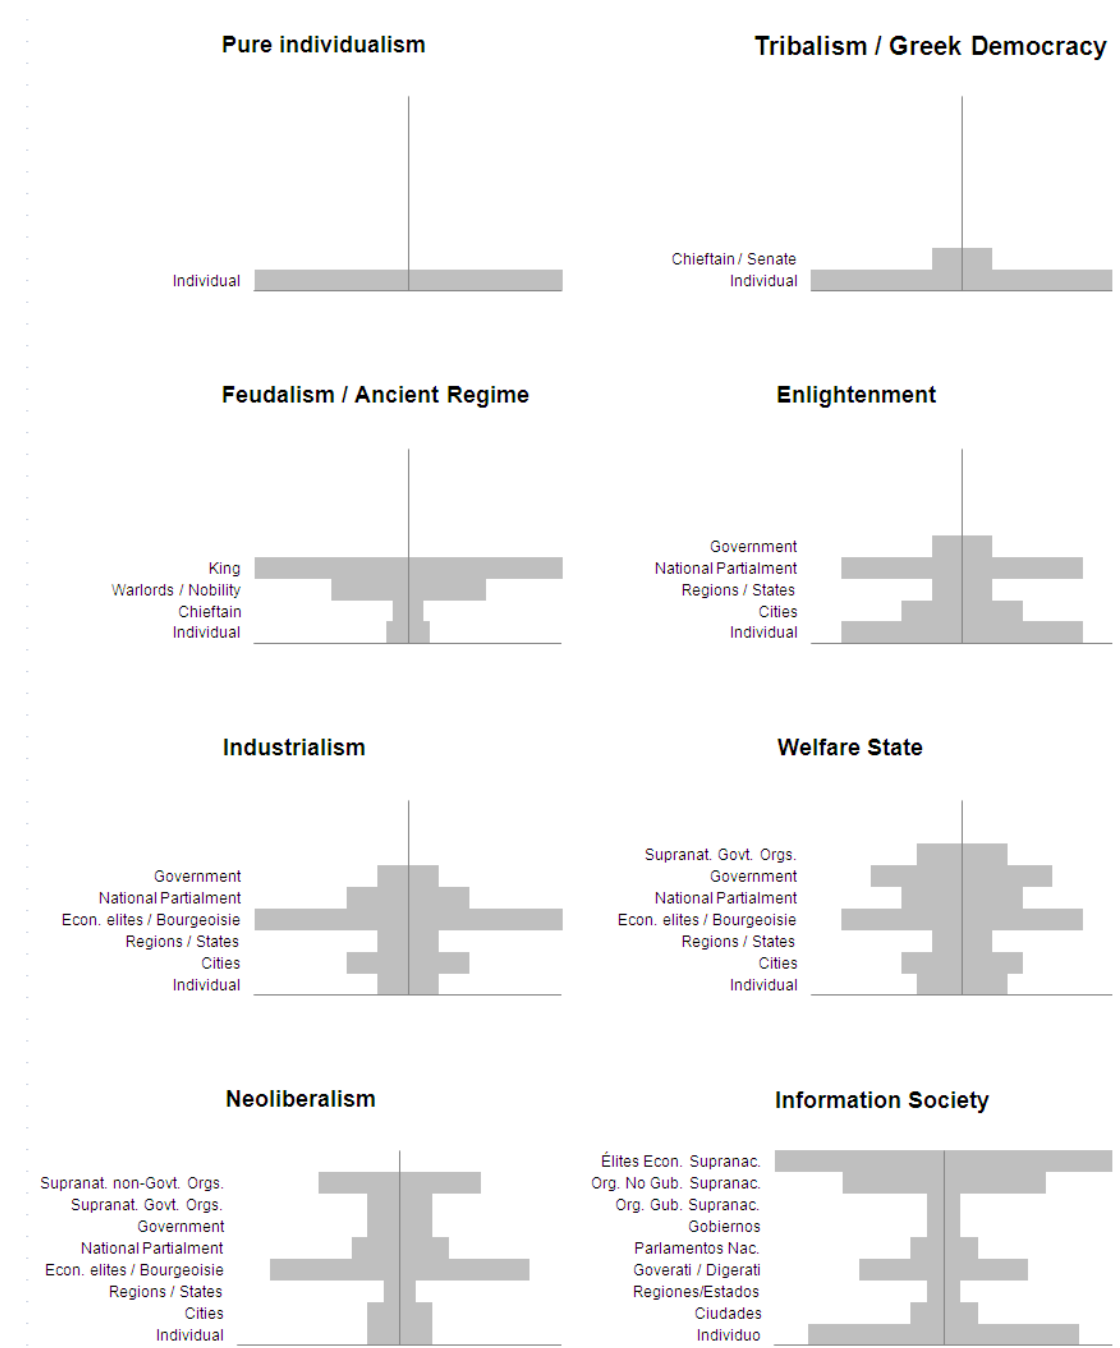
Figure 5: Pyramids of power along time. Horizontal axis measures a rough approximation to the distribution of power that different social organizational strata (vertical axis) share, from the bottom (the individual) to the top (supranational structures). Names of historical stages and social strata are only for depictive